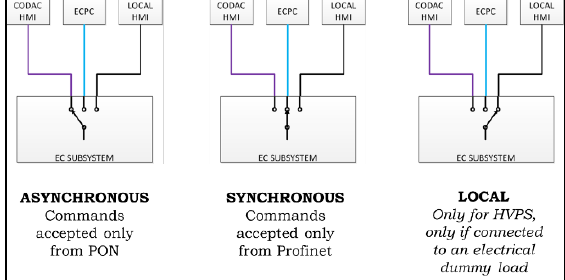
Fig. 10. Segregation and source of commands for the EC